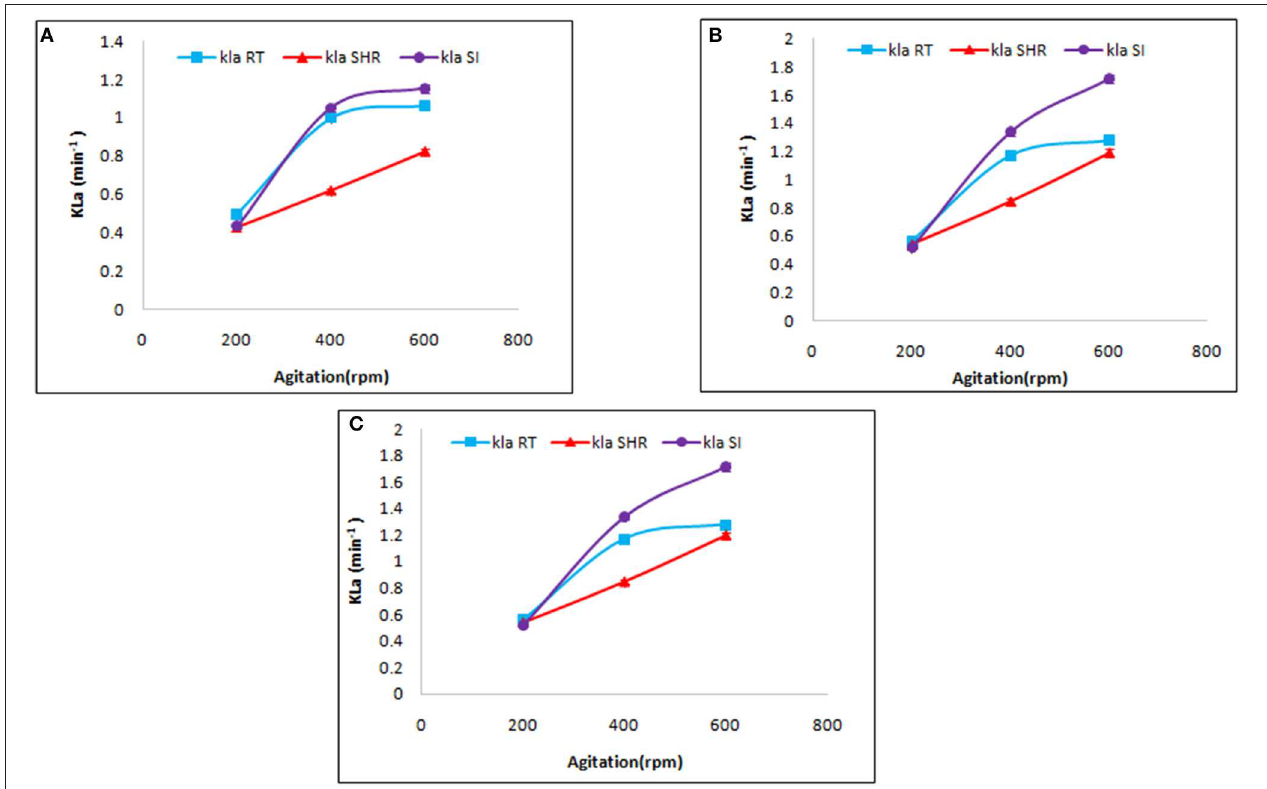
FIGURE 2 | Effect of aeration and agitation rate on volumetric mass transfer in aqueous system at (A) 0.5 vvm, (B) 1 vvm, and (C) 1.5 vvm aeration. The graph represents the effect of single helical ribbon (SHR), Rushton turbine (RT), and Smith turbine (SI) impellers on mass transfer at varying rates of aeration (0.5, 1, and 1.5 vvm) and agitation (200, 400, and 600 rpm). SI was found to be the most efficient impeller amongst others.